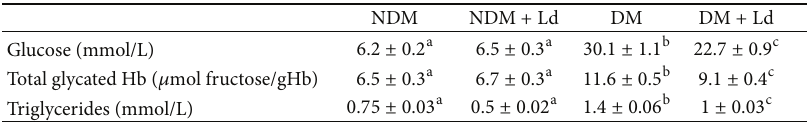
The difference was considered statistically significant at 𝑃 <